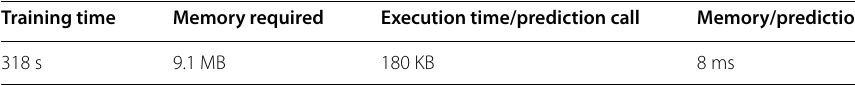
Table 4 Experimental results—quantitative characteristics